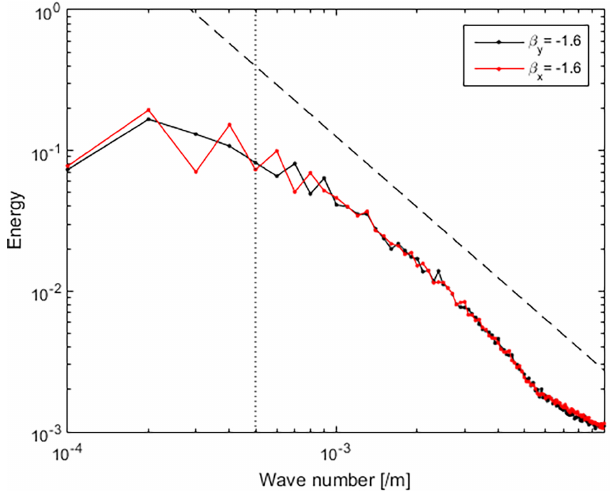
Figure 1. One-dimensionally averaged horizontal spectral slope of the cirrus following the x axis (in red) and the y axis (in black). The spectral slope of a − 5 / 3 theoretical signal is drawn (dashed line). Spectral slope values, between parentheses, are estimated between 5 × 10 − 3 m − 1 wave number (vertical dotted line) and the Nyquist wave